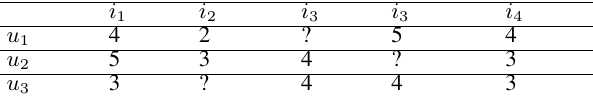
Table 3. User movie rating example.